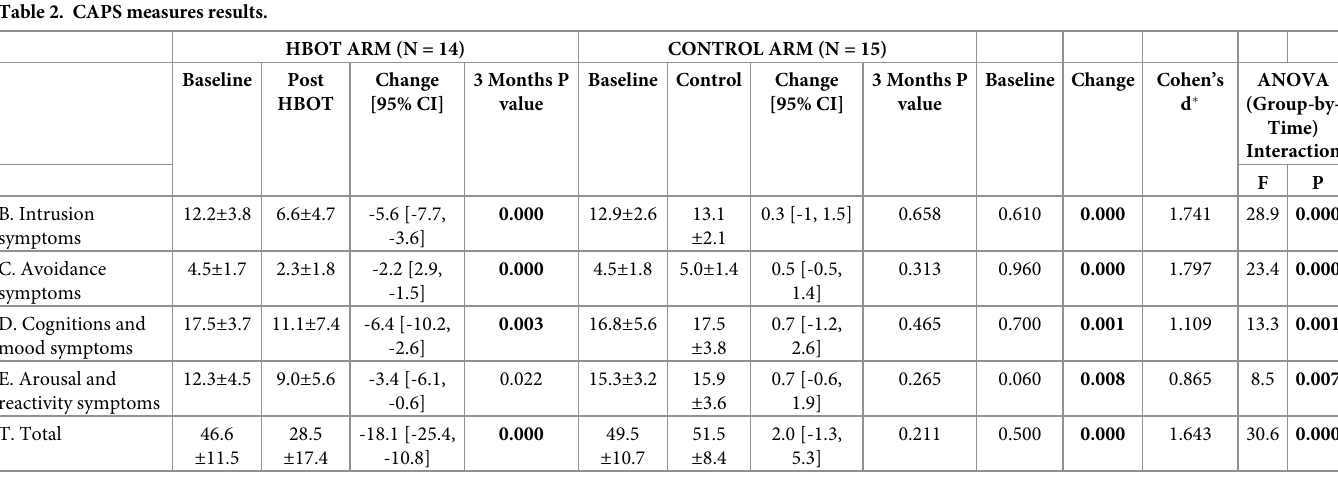
Table 2. CAPS measures